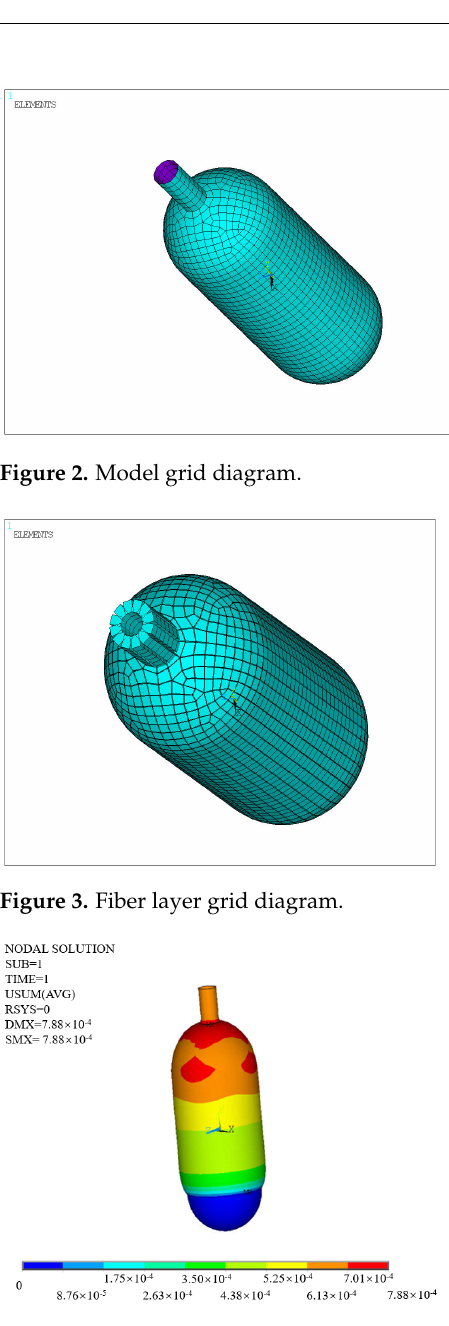
Figure 4. Displacement cloud diagram.